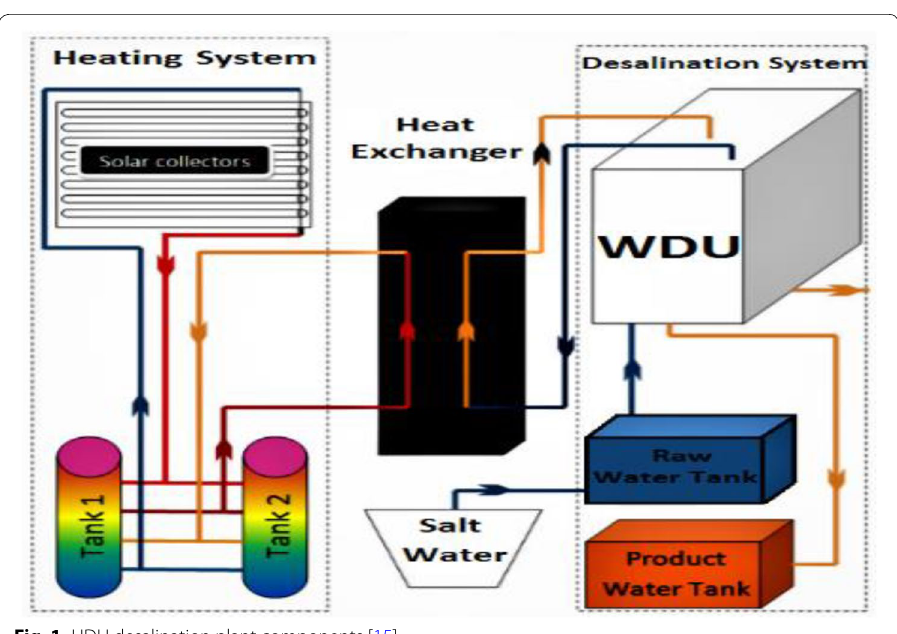
Fig. 1 HDH desalination plant components